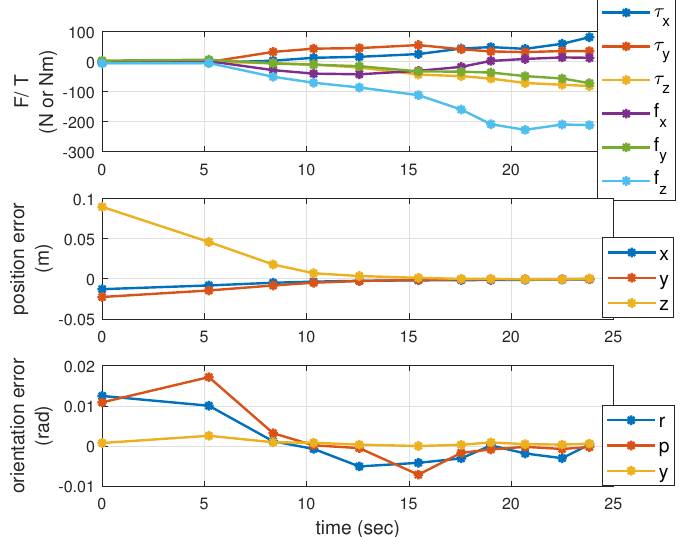
Figure 9. Under force and vision feedback, the placement force converges to the specified 200 N to en- sure secure seating in the nest, and the position and orientation alignment is achieved towithin 1 mm and 0.1 degree,